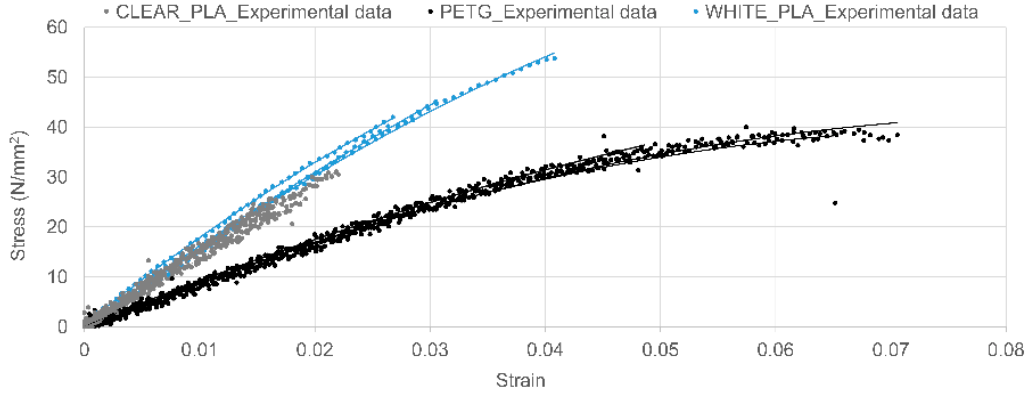
Figure A1. Stress-Strain graph of solid tubular specimens printed using clear PLA, white PLA and PE. Table A1 3D printed material properties: elongation at break, tensile modulus evaluation (Coefficients of variation provided in parentheses).